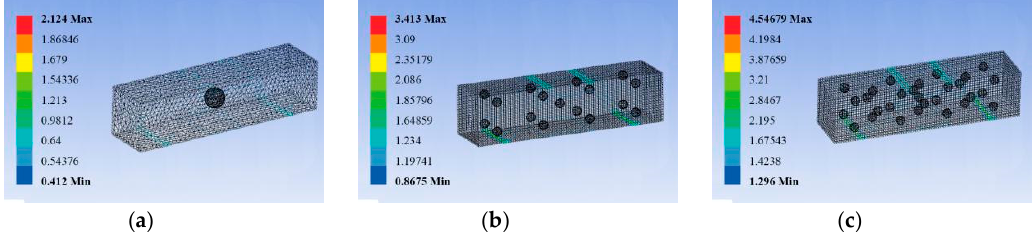
Figure 11. Simulation model of compressive strength (Strain). ( a ) Aggregated completely, ( b ) dispersion ratio of 50%, ( c ) dispersion ratio of 100%.